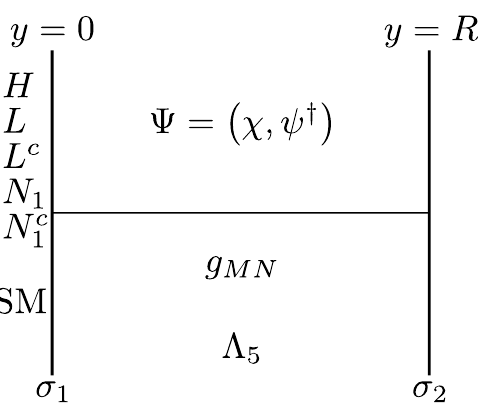
Figure 2 . Geography of the model. The horizontal axis represents the coordinate distance y in the extra dimension, while the vertical scale is representative for one of the usual four spacetime dimensions. Standard Model (SM) (cid:12)elds, including the Higgs (cid:12)eld H , are con(cid:12)ned to a 3-brane (depicted as a thick vertical line) at y = 0 with tension (cid:27) 1 . The 3-brane is also populated by electroweak-charge fermions L and L c , which couple to H and a pair of neutral fermions N 1 and N c through a Yukawa coupling. A bulk fermion (cid:9) couples to this new fermion sector via a brane- 1 localized mixing term with N c , indirectly communicating the vacuum expectation value of H to the 1 bulk via the Casimir stress of (cid:9). This Casimir stress, along with (cid:27) 1 , the tension (cid:27) 2 of the y = R brane, and the bulk cosmological constant (cid:3) 5 , determine the geometry of the space through their e(cid:11)ect on the metric g MN . We assume the 5D space to be orbifolded around y = R , so that there is a second copy of the interval attached to the branes on opposite